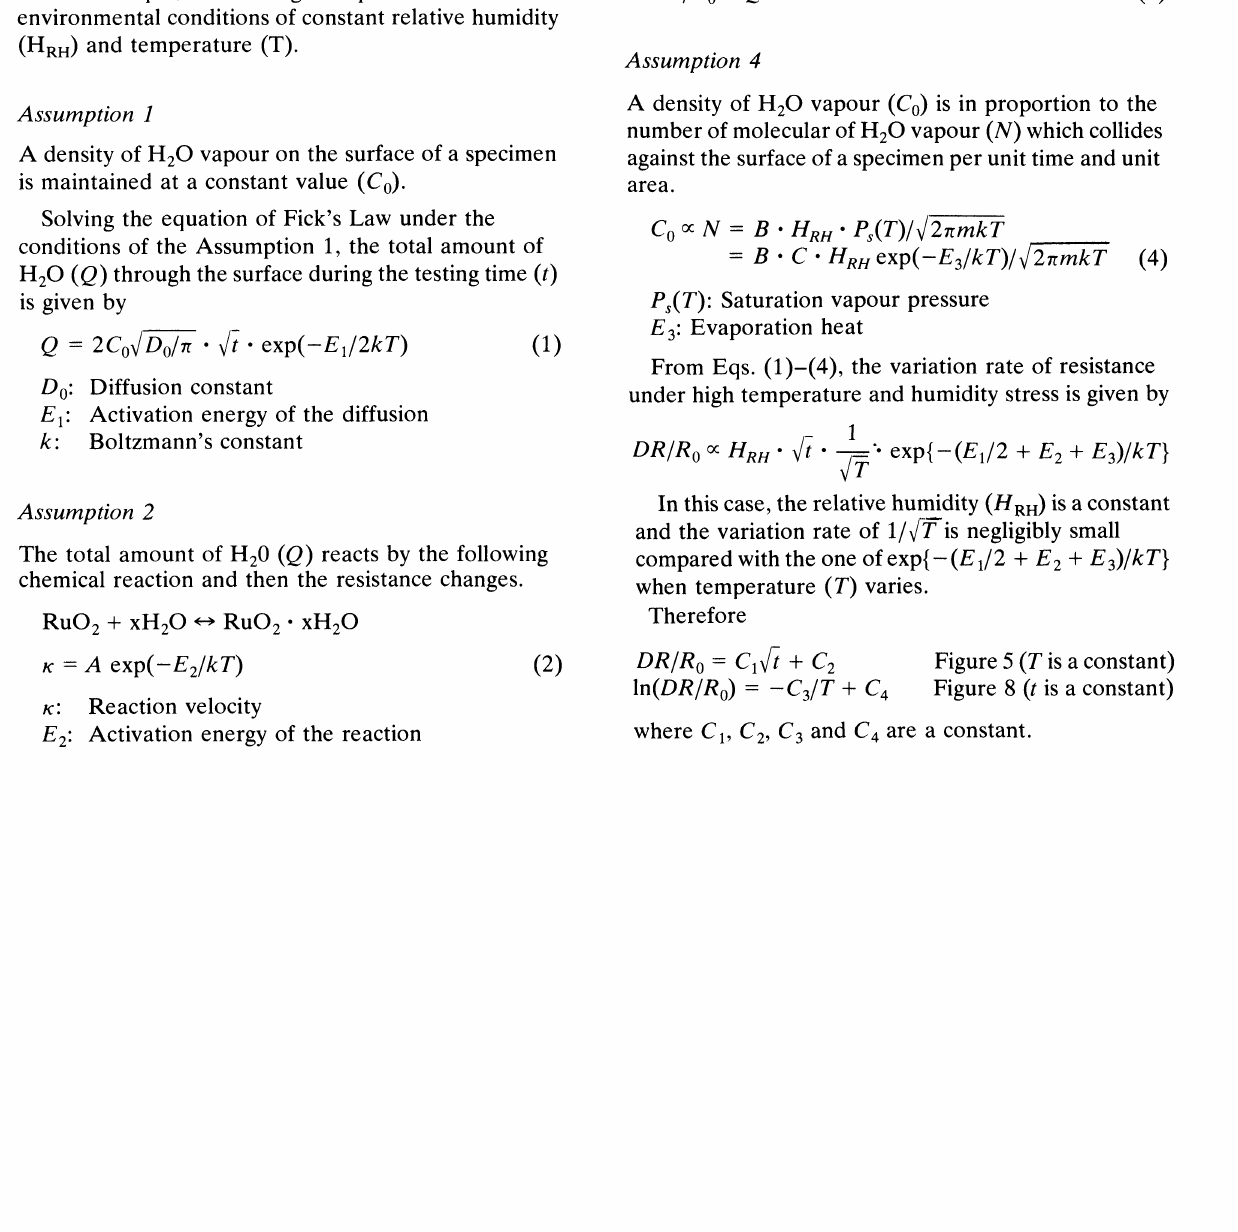
Figure 5 (T is a constant) Figure 8 (t is a constant) are a 4